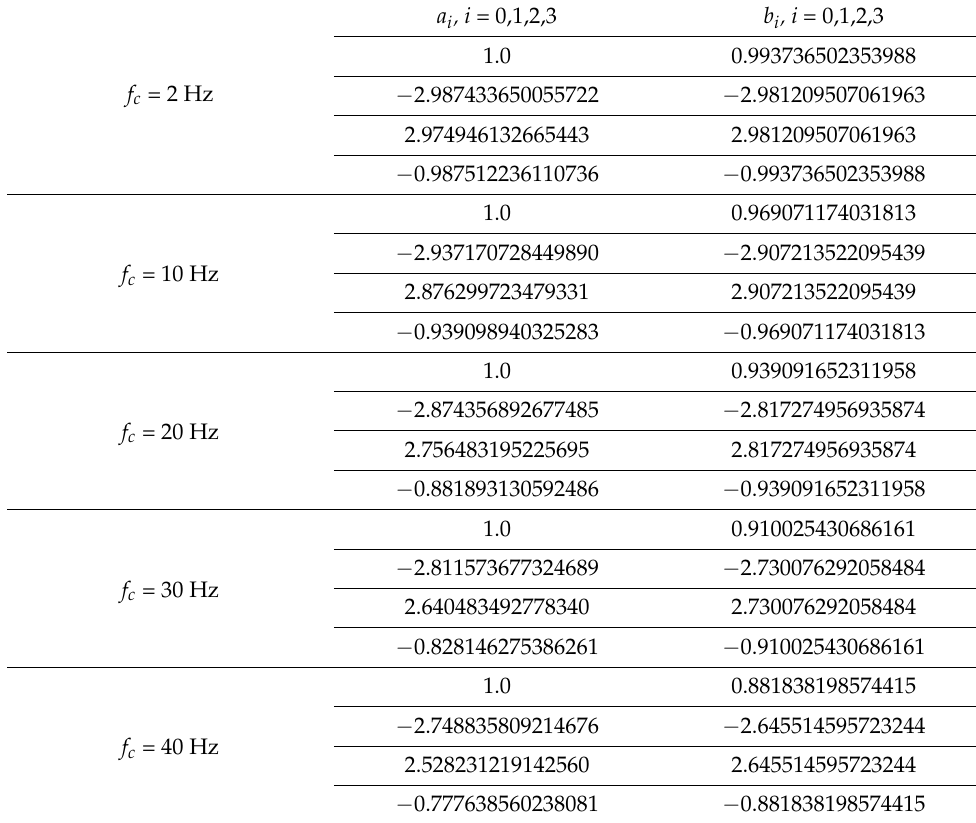
Table 1. Third order HP Butterworth filter coefficient value sets for removing low-frequency compo- nents from an EMG